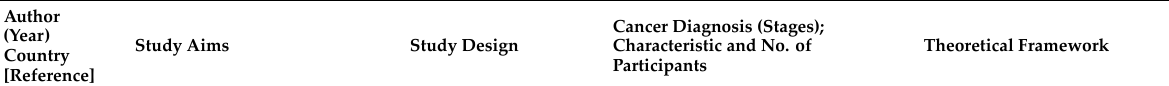
Table 1. Characteristics of included